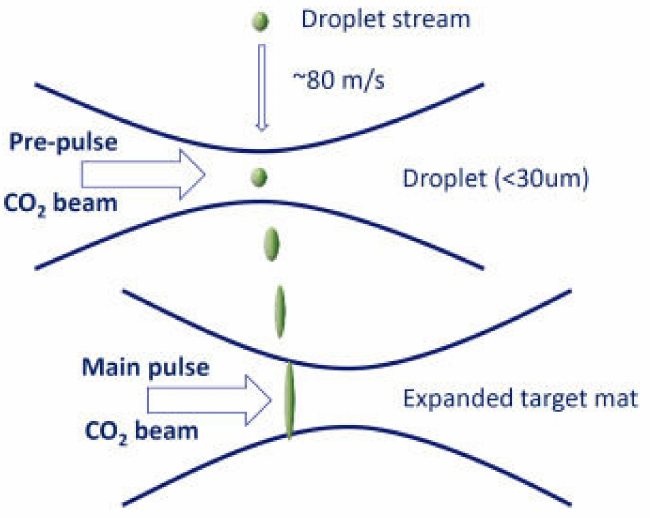
Figure 7. View of EUV generation and target formation. Reprinted with permission from